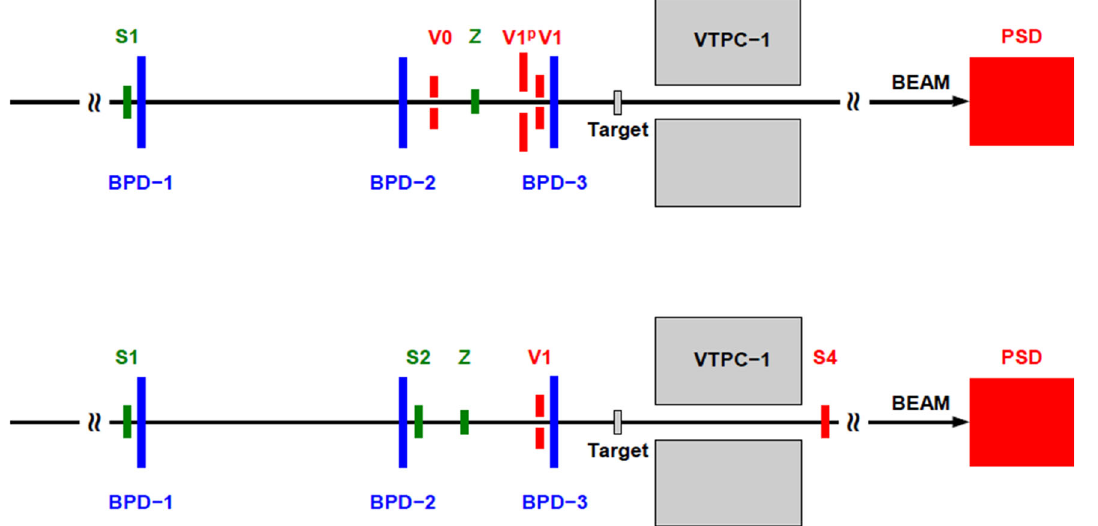
Fig. 2 The schematic of the placement of the beam and trigger detectors in high momentum ( top ) and low momentum ( bottom ) data taking